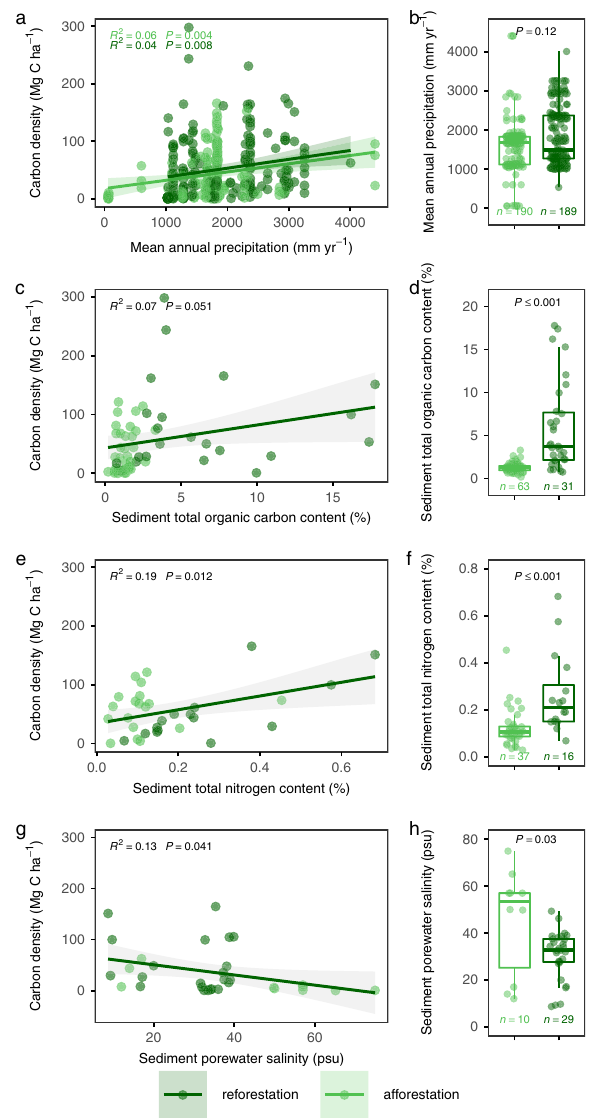
Fig.3|Relationshipofabovegroundbiomasscarbondensitywithmeanannual precipitation and sediment properties for mangrove restoration. a , c , e , g , Relationship of aboveground biomass carbon (AGC) density with mean annual precipitation (MAP), sediment total organic carbon content, total nitrogen content, and porewater salinity. Lines in a , c , e , g represent the ordinary least squares regression, with shading representing the 95% con fi dence interval of regression fi ts. psu refers to practical salinity units. b , d , f , h , Comparisons of MAP and sediment properties between reforestation and afforestation sites. Note that some sites with belowground biomass or sediment organic carbon density but withoutabovegroundbiomassdataarealsoincludedin b , d , f , h .Foreachboxplot, components are as detailed in Fig. 1. Signi fi cance level of difference between reforestation and afforestation is calculated by the Wilcoxon two-sided